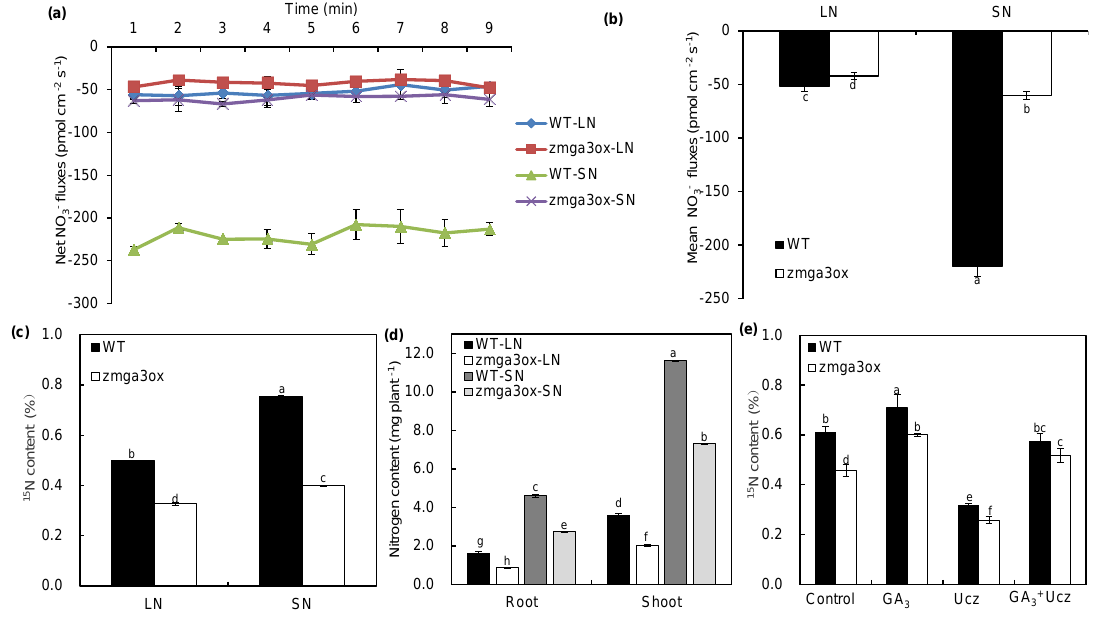
Figure 4. Nitrate uptake and allocation in zmga3ox plants under LN and SN conditions. ( a – b ) The net NO 3- flux ( a ), and the mean NO 3- flux (b) along the maturation zone of wild-type and zmga3ox primary root. Values were the means ± SD ( n = 7). ( c ) The 15 N content after 10 min 15 N tracing assay in wild-type and zmga3ox plants; ( d ) total N content per plant in shoots and roots of wild-type and zmga3ox plants; ( e ) the 15 N content in wild-type and zmga3ox seedlings treated with GA 3 and/or uniconazole (Ucz). ( c – e ) Values were the means ± SD ( n = 3). Different letters indicated significant difference calculated by Fisher’s LSD ( p < 0.05).